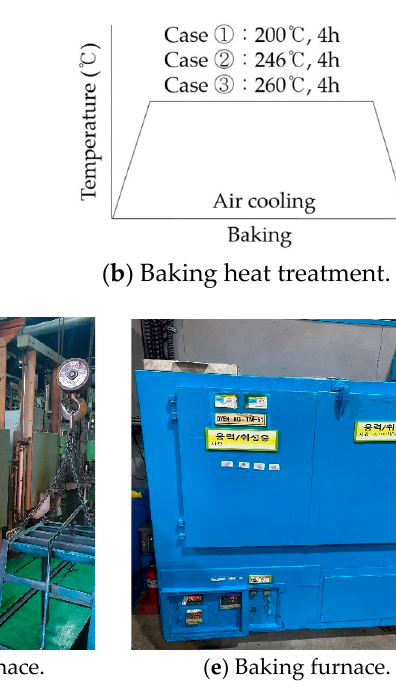
Figure 1. Heat treatment processes and the appearances of used furnace. Table 1. Chemical composition of the 4340M steel (in wt.%). [14].